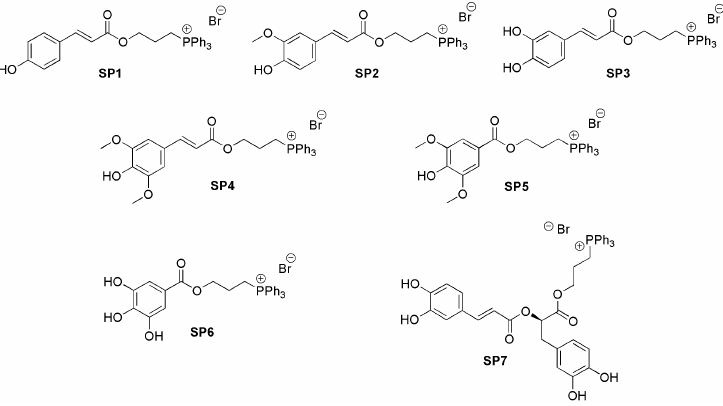
Figure 1. Structures of the synthesized MITO-phenolic derivatives SP1-7 . SP1 : MITO-coumaric ester; SP2 : MITO-ferulic ester; SP3 : MITO-caffeic ester; SP4 : MITO-sinapic ester; SP5 : MITO-syringic ester; SP6 : MITO-gallic ester; SP7 : MITO-rosmarinic ester.